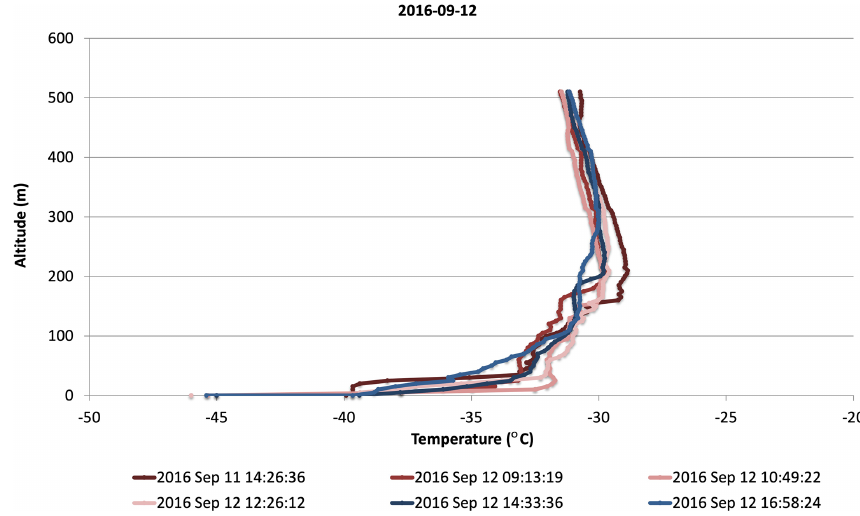
Figure 5. SUMO observed temperature profiles (colored lines) at the Pegasus ice runway from 14:26UTC, 11 September 2016, to 16:58UTC, 12 September 2016.